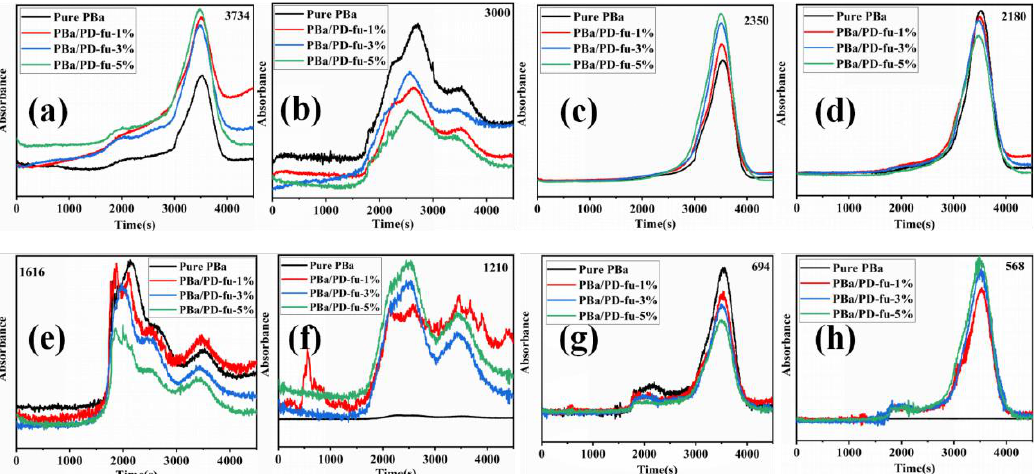
Figure 12. The analysis of pyrolysis products for neat PBa, PBa/PD-fu-1%, PBa/PD-fu-3% and PBa/PD-fu-5%: ( a ) water and ammonia gas, ( b ) alkane-containing compounds, ( c ) CO 2 , ( d ) CO, ( e ) and ( g ) aromatic compounds, ( f ) and ( h ) P–O and P=O compounds.